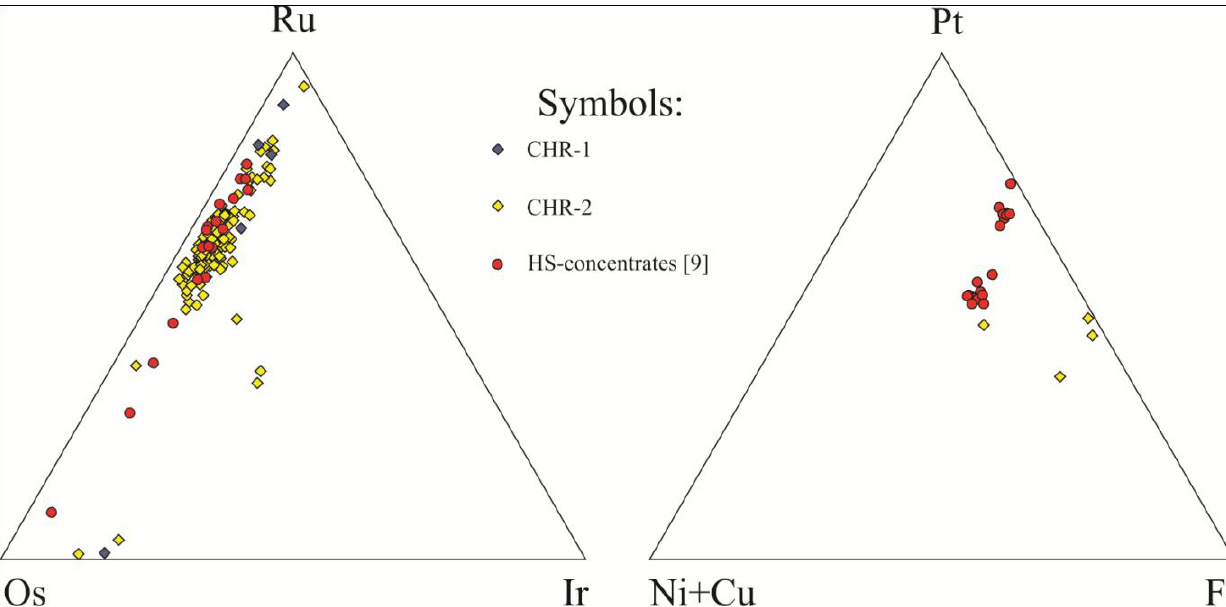
Figure 7. Ternary plot of Ru-Os-Ir sulfide and Pt-Fe alloy PGM associated with the chromitites of